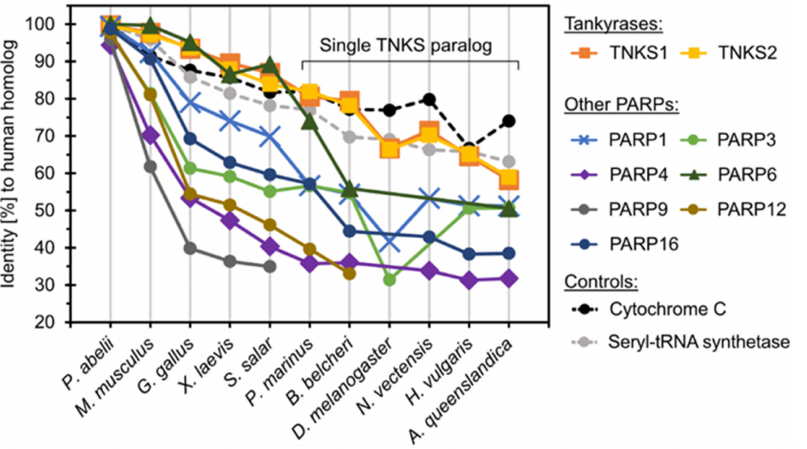
Figure 3. Sequence conservation of tankyrases and representative PARP proteins. For the different proteins analyzed, the graph shows the sequence identity shared by the human ortholog with orthologs from different metazoan species. The identities were determined from multiple sequence alignments of the orthologs from each set of ARTD family members. In species that only encode a single TNKS paralog, the sequence identity shared with human TNKS1 or TNKS2 was determined against the same TNKS ortholog. The conserved proteins cytochrome C and seryl-tRNA synthase were used for